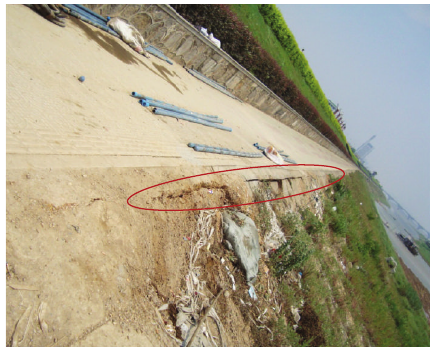
Figure 17: The surface uplift in the dike caused by